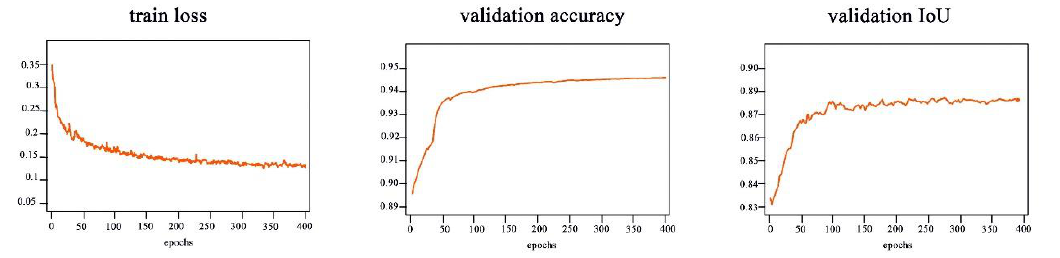
Figure 3 . Training loss, validation accuracy and validation IoU by training